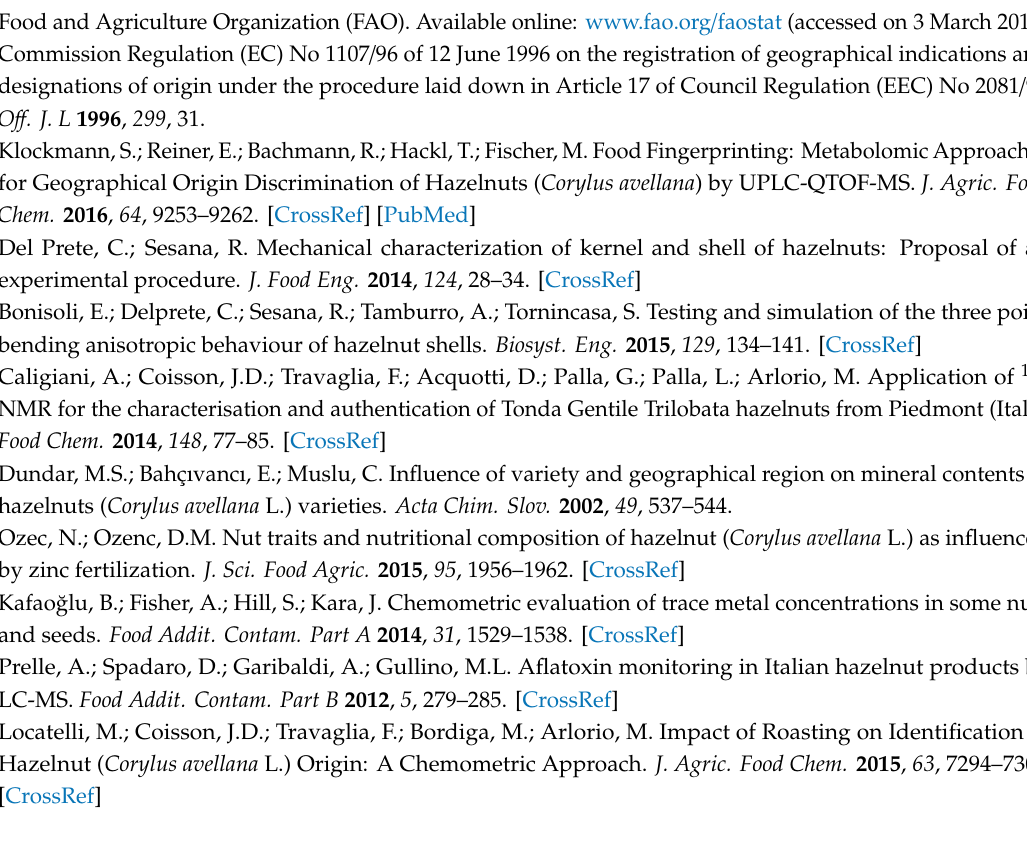
Table S1: Concentration of elements (mg · kg − 1 ) at T0 for O- and R-samples; Table S2: Concentration of elements (mg · kg − 1 ) in O-samples stored with A-Method; Table S3: Concentration of elements (mg · kg − 1 ) in O-samples stored with B-Method; Table S4: Concentration of elements (mg · kg − 1 ) in O-samples stored with C-Method; Table S5: Concentration of elements (mg · kg − 1 ) in O-samples stored with D-Method; Table S6: Concentration of elements (mg · kg − 1 ) in O-samples stored with E-Method; Table S7: Concentration of elements (mg · kg − 1 ) in R-D1-samples stored with A-Method; Table S8: Concentration of elements (mg · kg − 1 ) in R-D1-samples stored with B-Method; Table S9: Concentration of elements (mg · kg − 1 ) in R-D1-samples stored with C-Method; Table S10: Concentration of elements (mg · kg − 1 ) in R-D1-samples stored with D-Method; Table S11: Concentration of elements (mg · kg − 1 ) in R-D1-samples stored with E-Method; Table S12: Concentration of elements (mg · kg − 1 ) in R-D2-samples stored with A-Method; Table S13: Concentration of elements (mg · kg − 1 ) in R-D2-samples stored with B-Method; Table S14: Concentration of elements (mg · kg − 1 ) in R-D2-samples stored with C-Method; Table S15: Concentration of elements (mg · kg − 1 ) in R-D2-samples stored with D-Method; Table S16: Concentration of elements (mg · kg − 1 ) in R-D2-samples stored with E-Method; Table S17: Concentration of elements (mg · kg − 1 ) in O-samples roasted and not roasted, stored with B-Method and C-Method at T0 and T4; Table S18: Concentration of elements (mg · kg − 1 ) in R-D1-samples roasted and not roasted, stored with B-Method and C-Method at T0 and T4; Table S19: Concentration of elements (mg · kg − 1 ) in R-D2-samples roasted and not roasted, stored with B-Method and C-Method at T0 and T4; Table S20: Concentration of elements (mg · kg − 1 ) in Pm samples; Table S21: Concentration of elements (mg · kg − 1 ) in Pr samples; Figure S1: Biplot obtained by PCA (PC1 vs. PC2) including hazelnuts from Piedmont in the main